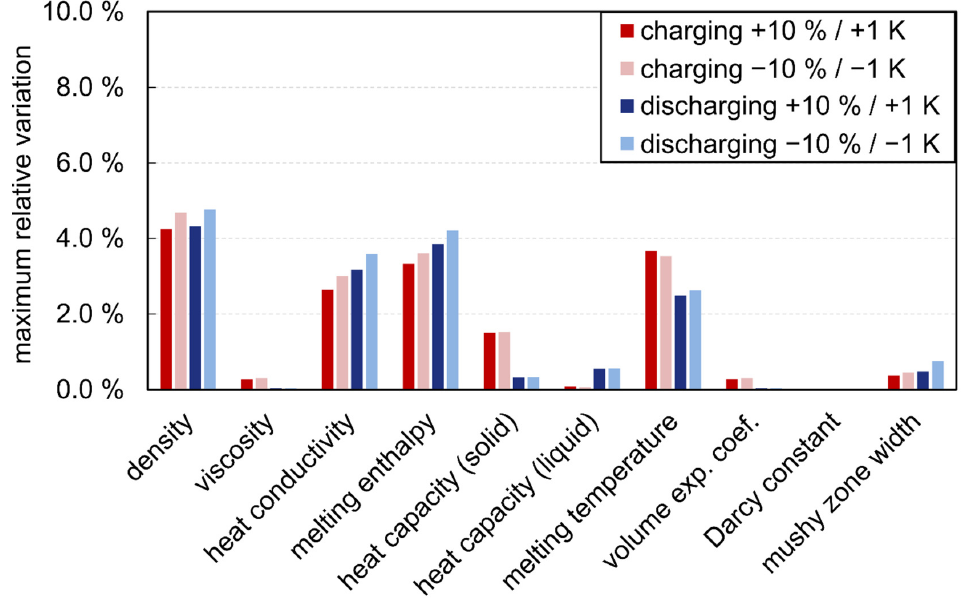
Figure 8. Absolute maxima of the relative variation of the global liquid fraction for charging and discharging when varying the material properties by ±10% or ±1 K .